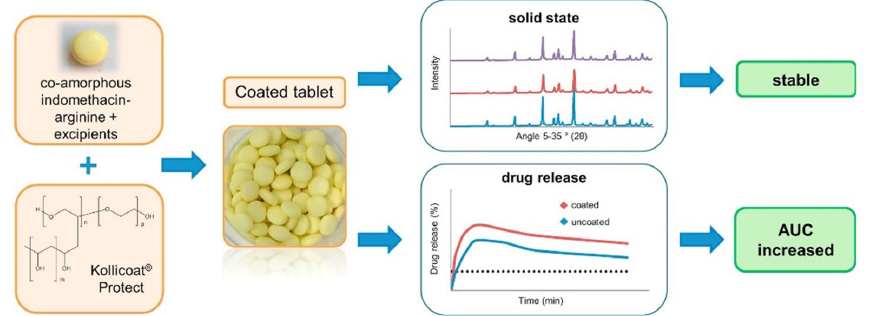
Figure 13. Preparation of stable polymer-coated tablets of co-amorphous materials [101].